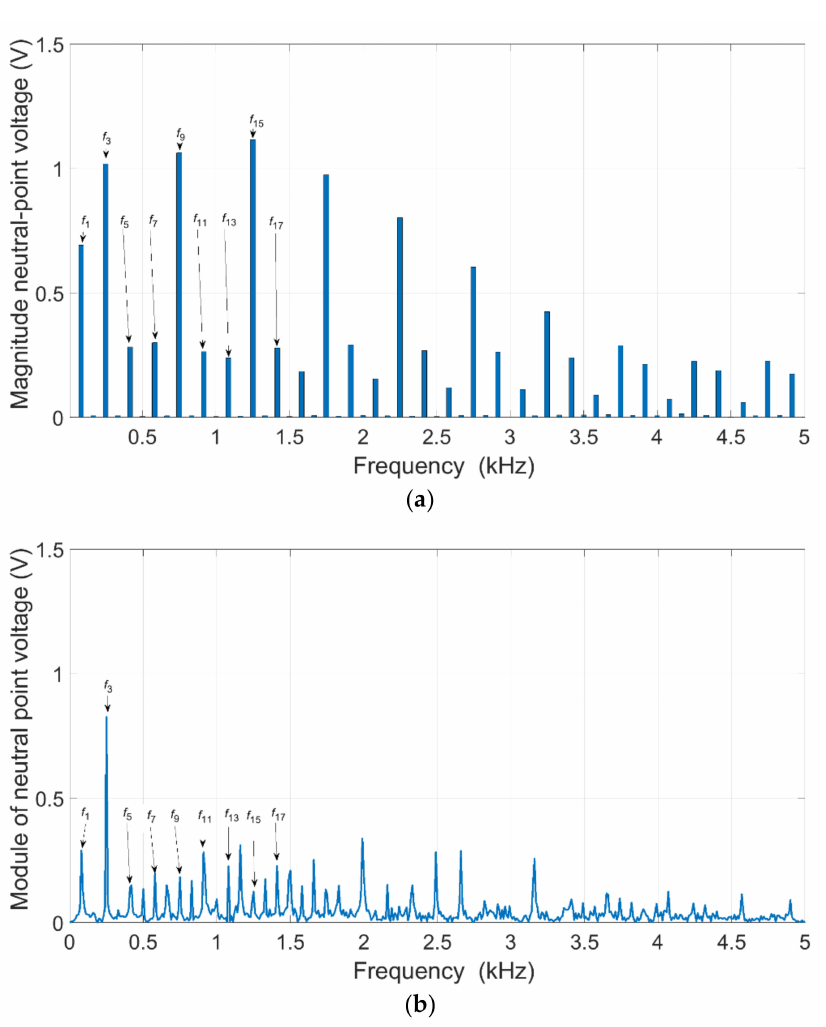
Figure 8. Y configurations—FFT of neutral voltage—SC: ( a ) numerical calculations, ( b )